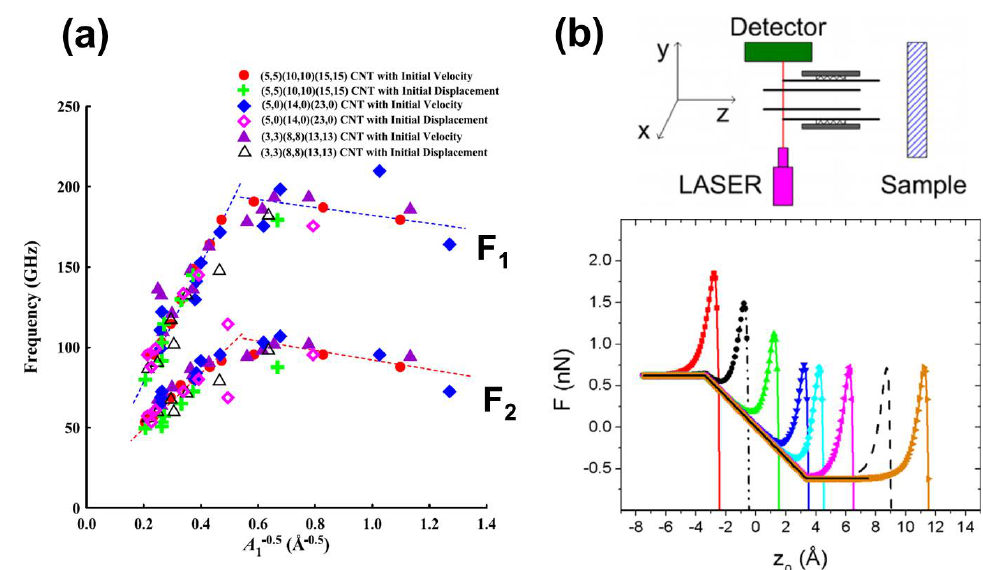
Figure 11. ( a ) The primary ( F 1 ) and the secondary ( F 2 ) frequencies of a TWNT oscillator plotted against the oscillation amplitude ( A 1 ) related to F 1 [168]. ( b ) The top panel shows the design of an atomic force microspe (AFM) system in which DWNTs would be used as surface probes. The bottom panel shows the intensity of the force between the inner tube of the DWNT and the sample plotted against the distance between the surface and the edge of the outer tube of the DWNT. The free oscillations of the DWNT system have a constant intensity around 0.62 nN, and as the DWNT starts interacting with the sample, a region of a linear force regime dominates